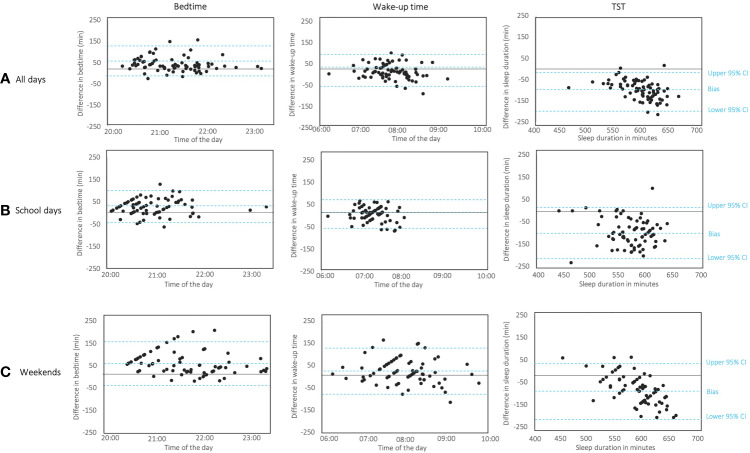
Bland-Altman plots to assess the limits of agreement between actigraphy and sleep diary for bedtime (on the left), wake-up time (in the middle) and Total Sleep Time (TST, on the right) according to (A) all days, (B) school days, and (C) weekends. Each child’s estimation is represented by a dot. Y-axis represents the difference between the two assessed measures being assessed; x-axis represents the average of the two methods. The horizontal line represents the bias; the two horizontal lines representing the 95% limits of agreement, which define the range in which 95% of the differences between methods are expected to fall and are calculated as the bias ± 1.96 standard deviation.